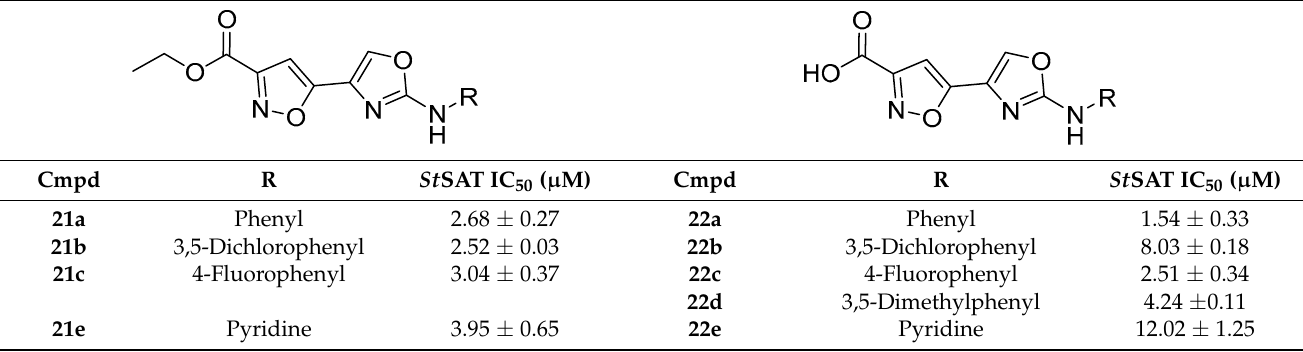
Table 3. St SAT Inhibitory activity of synthesised compounds 21a–c, 21e and 22 a–e.